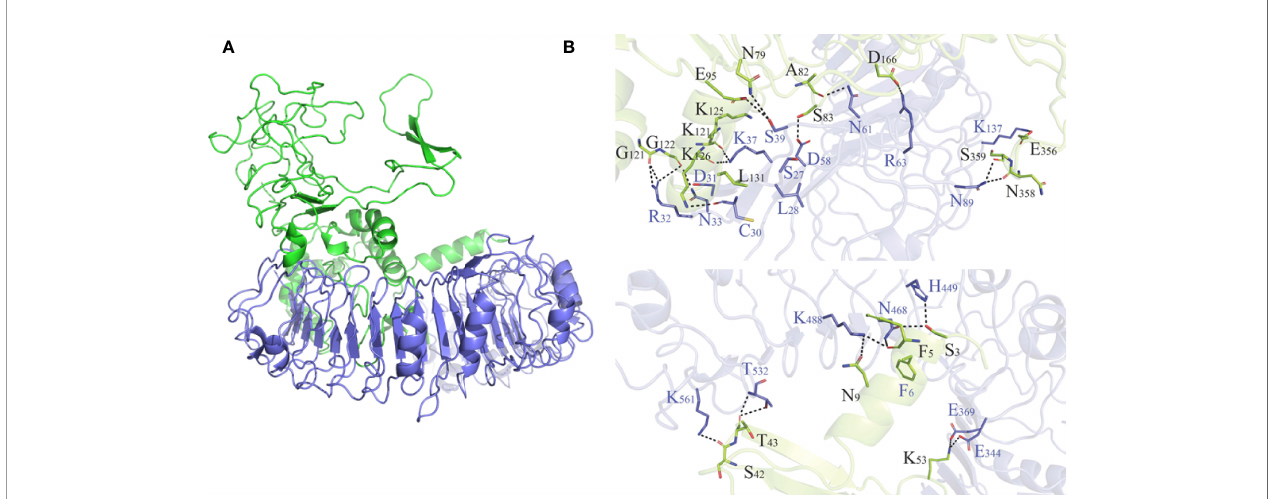
FIGURE 5 | (A) Diagram of the lowest energy docking mode of the vaccine-Toll like receptor (TLR) 2 complex. (B) Pattern diagram of the binding interface of the vaccine – TLR2 complex, the TLR2 is shown in blue, the vaccine is shown in yellow-green. The binding interface amino acid of TLR2 is shown in blue, the binding interface amino acids of vaccine are shown in black. The sticks refer to binding interface amino acids, and the black dotted lines refer to hydrogen bonds.